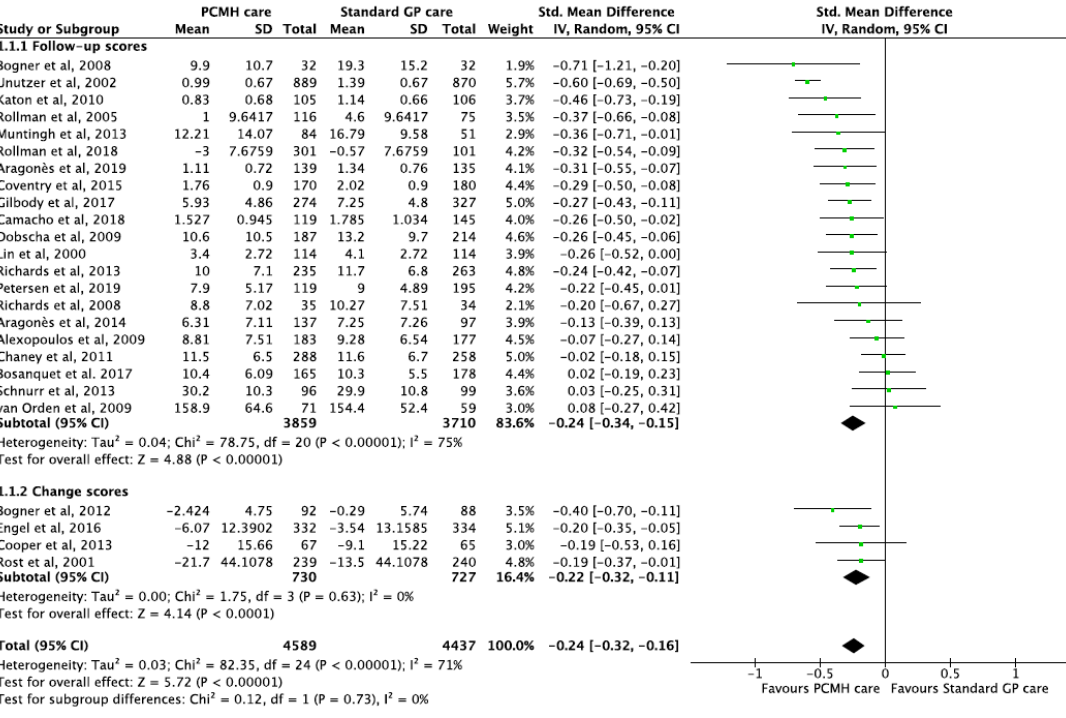
Figure 3. Forest plots of depression outcomes between the PCMH care and Standard GP care.